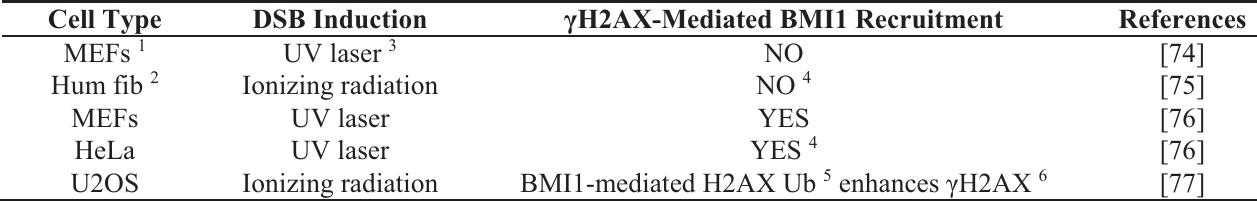
Table 1. (cid:2)H2AX nuclear foci dependent and independent BMI1 recruitment to double-stranded DNA breaks